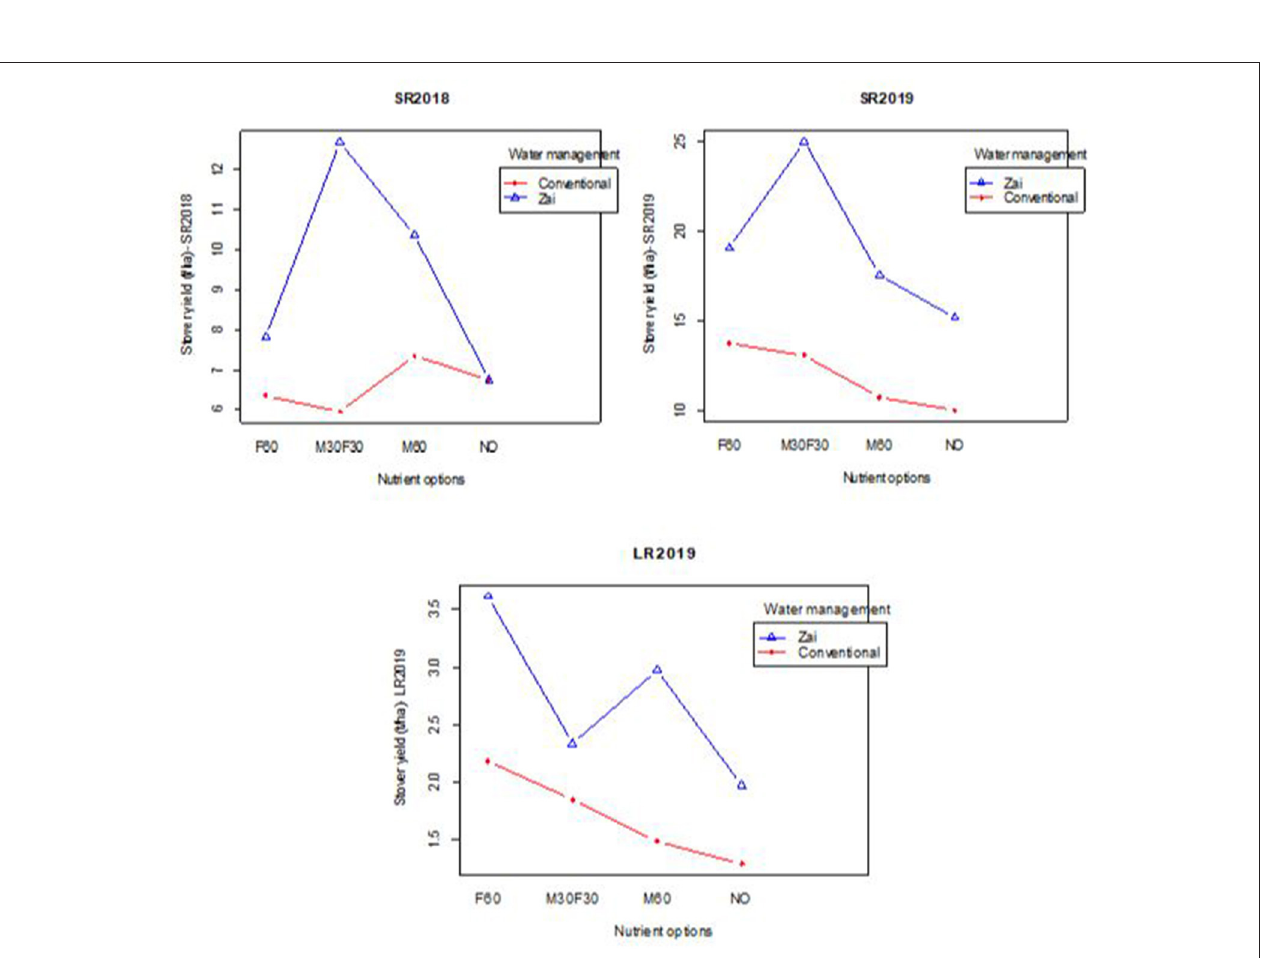
FIGURE 6 | Interaction effect of Zai technology and selected nutrient amendment options on Sorghum stover yield in the Short rains’ seasons, 2018 and 2019 (SR18 and SR19) and long rain season 2019 (LR19). NO, No inputs; M60, Sole manure; F60, Full rate mineral fertilizer (60kg N ha − 1 ); M30F30, Manure + half rate mineral fertilizer (30kg N ha − 1